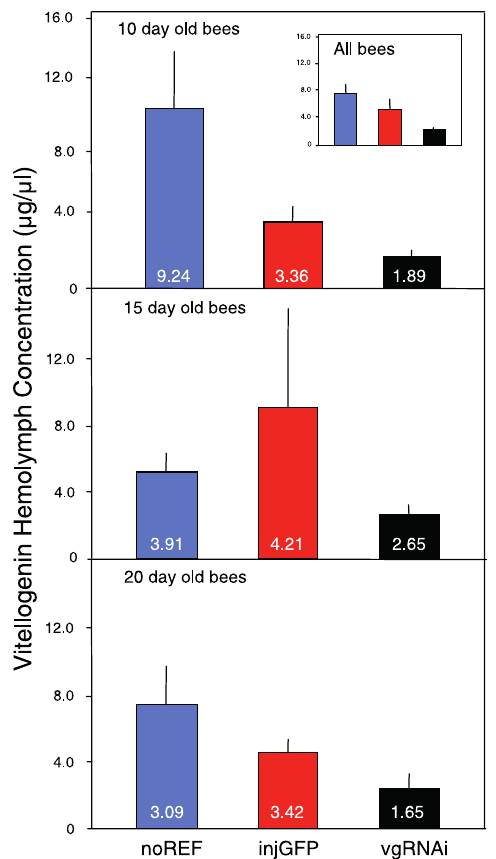
Figure 1. The Effect of vitellogenin RNAi on Hemolymph Vitellogenin Concentrations Levels are in micrograms per microliter relative to a b -galactosidase standard. Significant suppression of vitellogenin is apparent in RNAi knockdowns (vgRNAi) compared to injected controls (injGFP; Mann- Whitney U test: Z ¼ 2.84, n ¼ 54, p , 0.005). Control injections (GFP- derived dsRNA) did not significantly affect the vitellogenin level of the bees compared to the non-injected reference group (noREF; Mann- Whitney U test: Z ¼(cid:2) 1.10, n ¼ 55, p ¼ 0.27). Bars show results as means and standard errors with corresponding medians at the bottom of each bar. Because the dataset did not conform to assumptions of parametric tests (see Materials and Methods), medians can be considered the more accurate statistic. The dataset is split by age (10, 15 and 20 d olds) to visualize the persistence of RNAi. However, age did not affect the vitellogenin level of the workers ( p ¼ 0.68, see data analysis section for details), and thus conclusions cannot be drawn about treatment effects by age. The means and standard errors of the dataset overall are shown in the embedded box of the upper panel (medians for the dataset: noREF ¼ 3.94, injGFP ¼ 3.45, and vgRNAi ¼ 2.46).